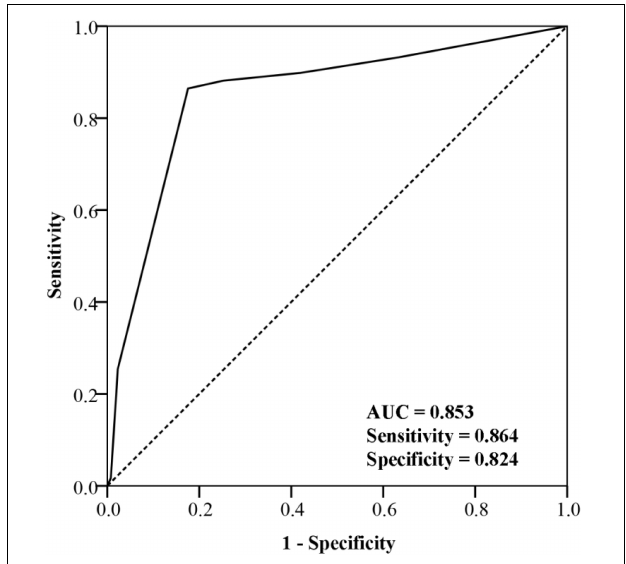
FIGURE 3 | Receiver operating characteristic curve of fluid-attenuated inversion recovery vascular hyperintensity score for prognosis prediction.